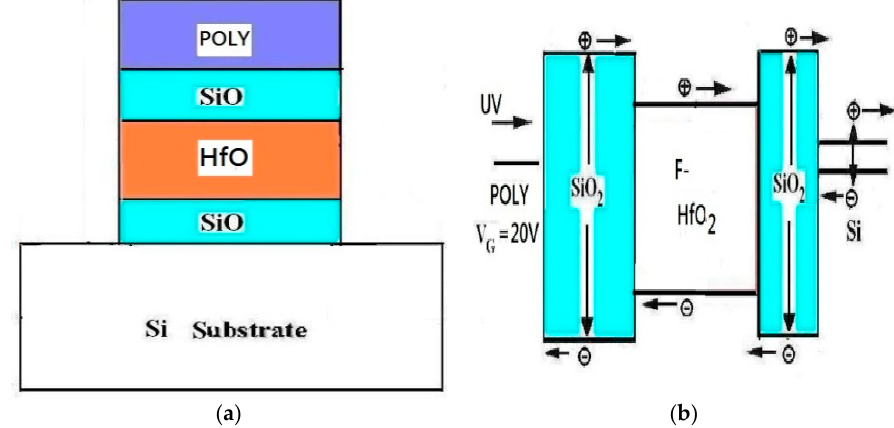
Figure 1. ( a ) Cross-sectional view of an SOHOS capacitor device; ( b ) Charge generation and trapping in the F-SOHOS capacitor after UV